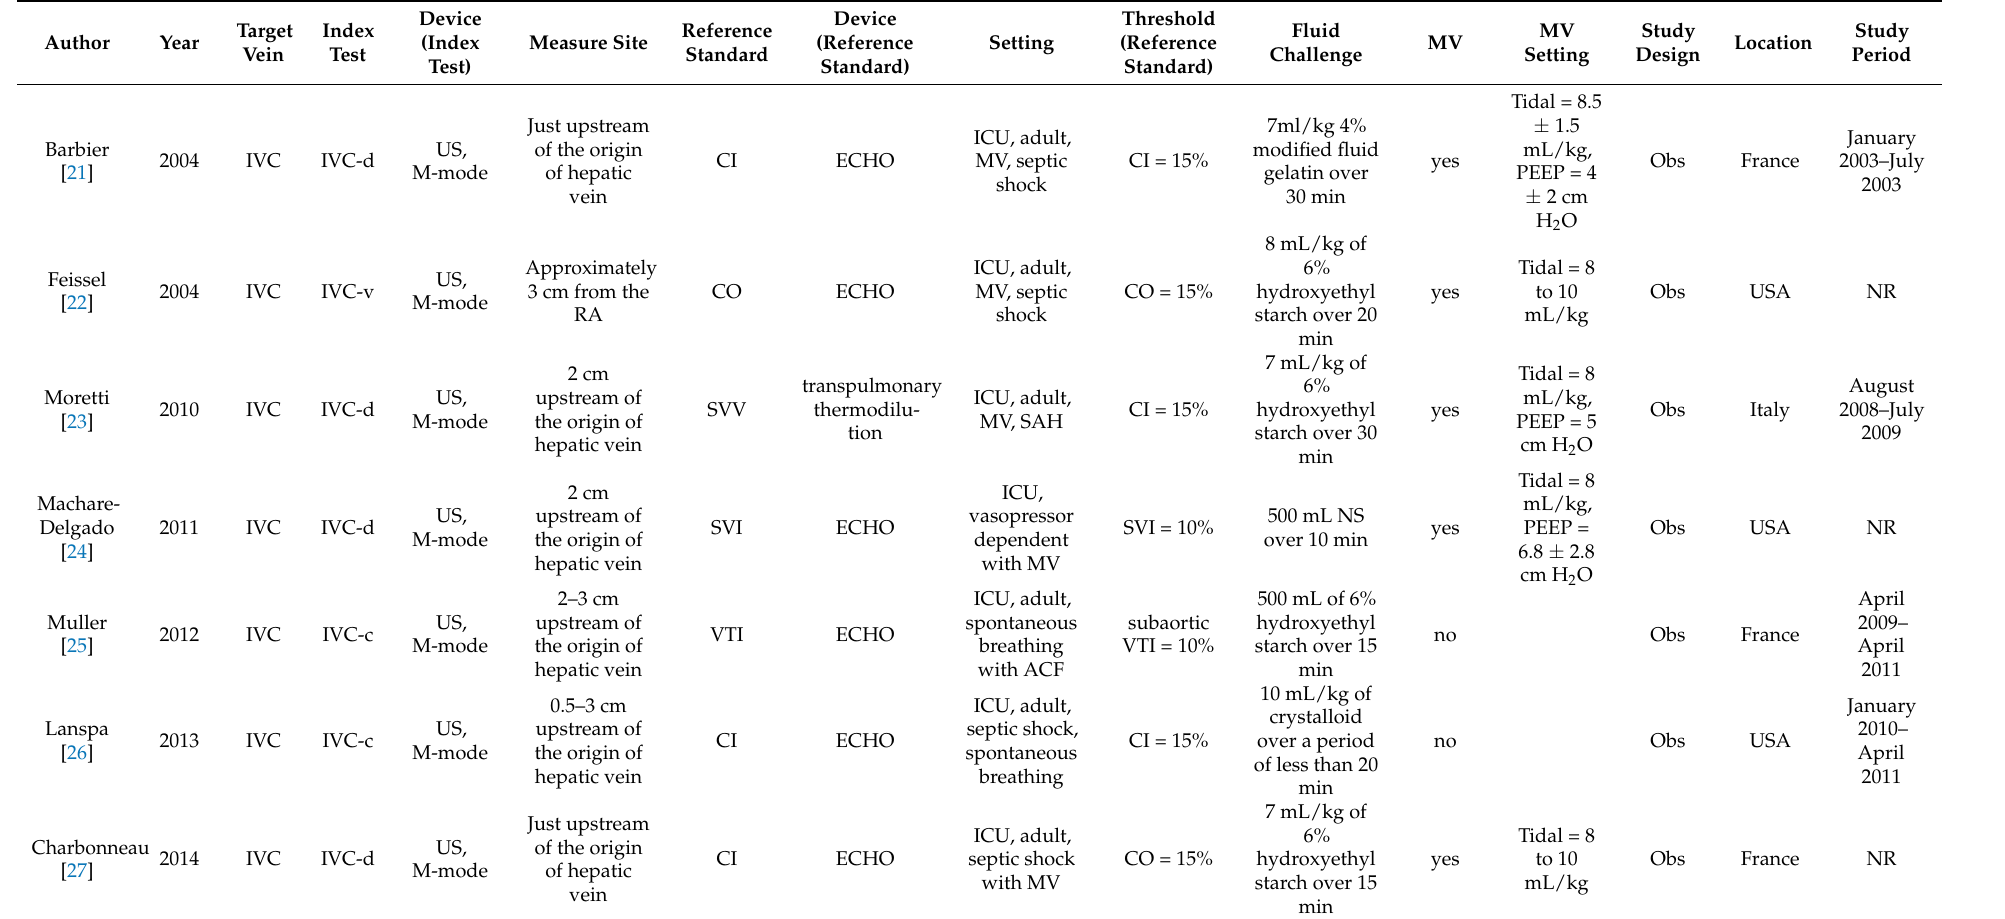
Table 1. Main characteristics of the eligible